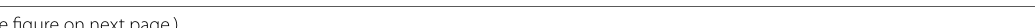
(See figure on next page.) Fig. 13 Results of FORC PCA on a set of FORC diagrams during heating in air for sample 102-1Z-3 shown in Fig. 12. a Variance explained by principal components (solid circles) shown together with cumulative variance (blue columns). 97% of variance is explained with PC1 and PC2 and three end members are recognized. b FORC for each heating step is plotted on PC2 versus PC1 diagram together with end members EM1, EM2 and EM3. FORC diagrams are shown for c EM1, d EM2 and e EM3. Color scales for d and e are the same as c . Horizontal profiles on FORC diagrams along 0 are shown for f EM1, g EM2 and h EM3. EM1 represents the component before heating. During heating, it gradually moves to EM2 at 400 °C. B u = After 400 °C it moves to EM3 around 450–500 °C then back to EM2 at 600